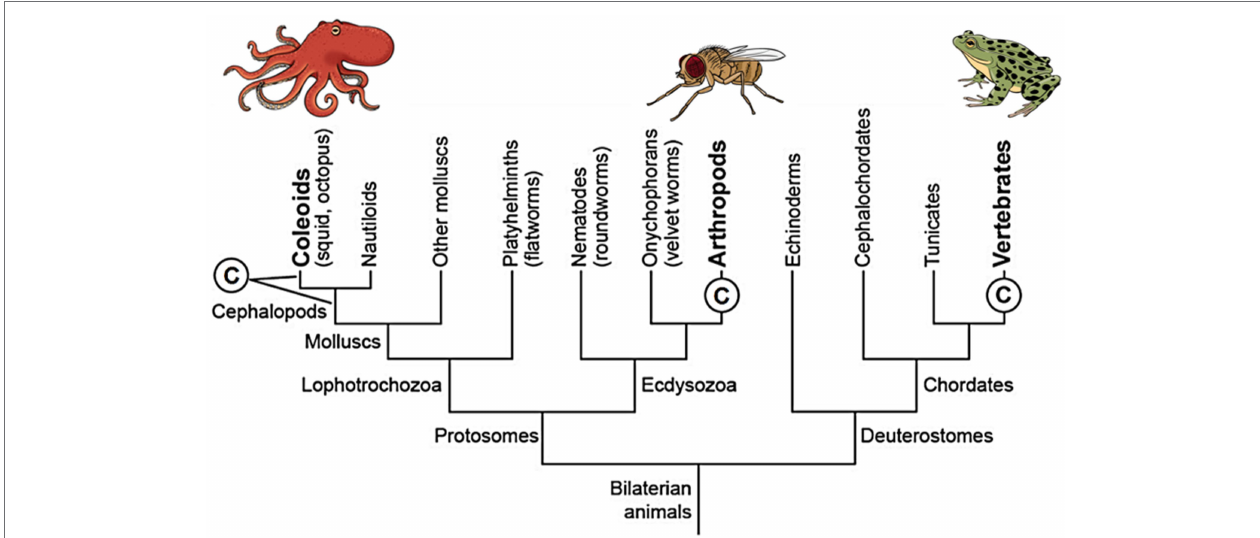
FIGURE 2 | A simplified phylogenetic tree of animal relationships showing that consciousness ( © ) emerged independently in three different lines of animals. At left, the two leaders extending from the © mean that we cannot tell whether the consciousness evolved in the first cephalopod mollusks or else in the coleoid ancestor of squid, octopus, and cuttlefish. Reproduced with the permission of the copyright holder Mount Sinai Health